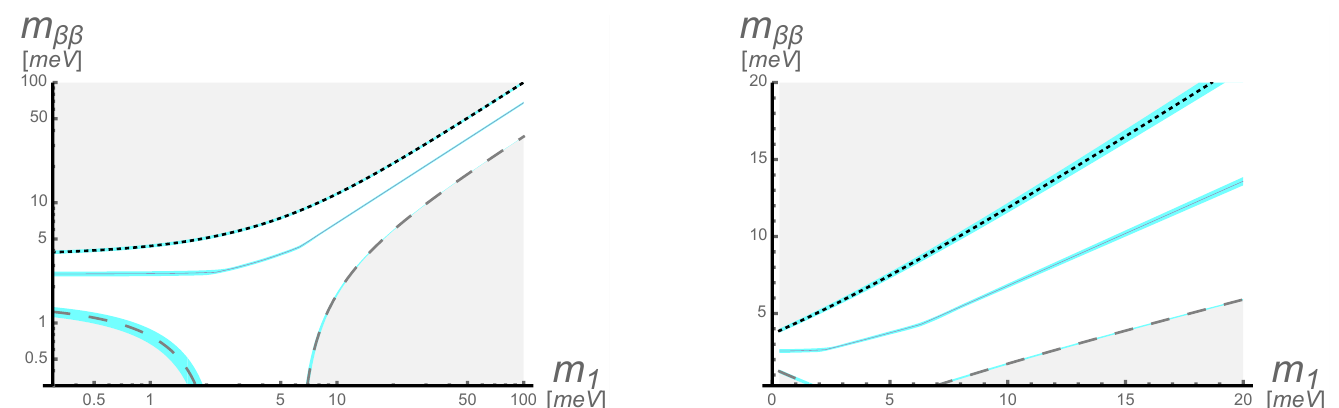
Figure 1. Allowed region for the parameter m ββ = m ee (white) assuming a normal mass spectrum. On the left, log-log graph; on the right, zoom in the region of the smallest m 1 somewhat favored by cosmology (see the text and Figure 4 of [134]). The central curve is the average value. The colored bands indicate the uncertainty regions (one sigma). Gray regions are incompatible with observed neutrino